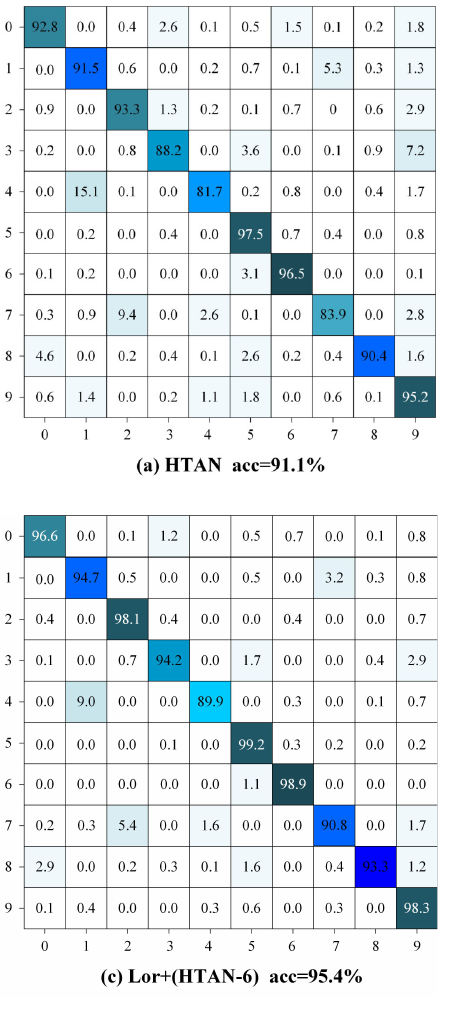
Figure 4. Confusion matrices for the digit adaptation (SVHN →